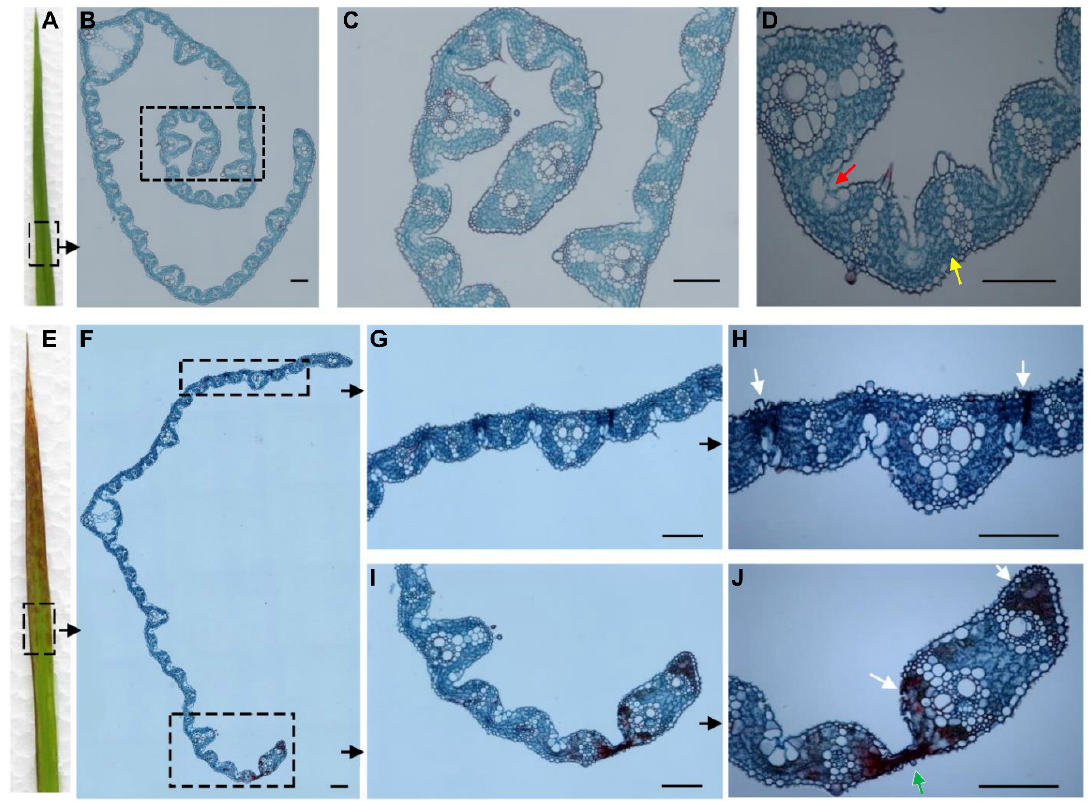
Figure 4. The microstructure of the leaf of WT and rls1 plants. ( A – D ) WT leaves feature normal mesophyll (yellow arrow) and bulliform (red arrow) cells; ( E – J ) The bulliform cells in the leaf margin of rls1 plants (green arrow) appear shriveled and atrophied. A portion of the mutant’s mesophyll cells appear atrophied and dead (white arrows). Bars: 100 µm.